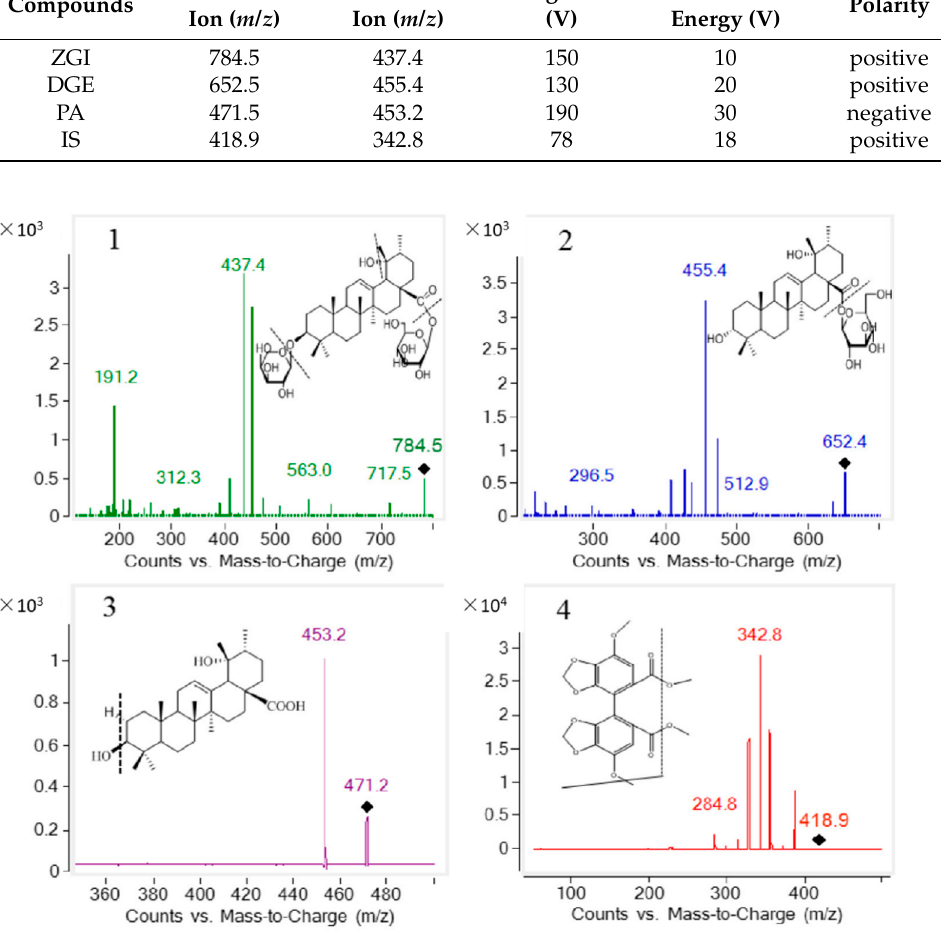
Figure 6. Product ion mass spectra of ZGI ( 1 ), DGE ( 2 ), PA ( 3 ), and bifendate (IS) ( 4